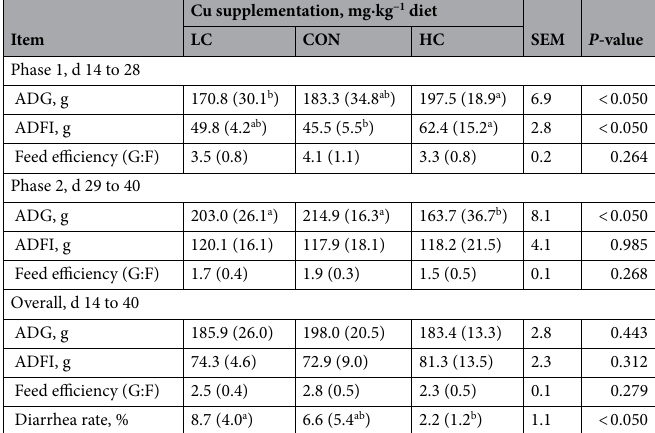
Table 1. Effects of dietary copper on the growth performance of suckling piglets [Mean (SD)]. a,b Values within a row without a common superscript letter are significantly different ( P < 0.05).